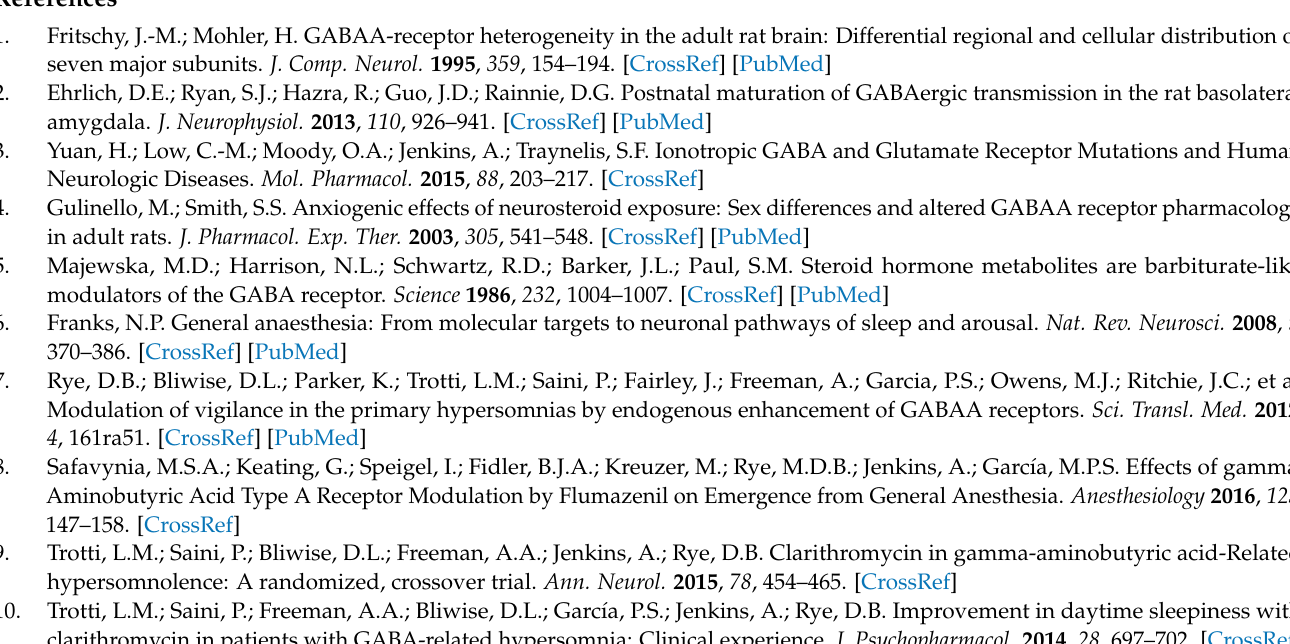
recording. Figure S2: Predicted binding pose for flumazenil. Figure S3: Detailed view of predicted binding poses for 10 compounds